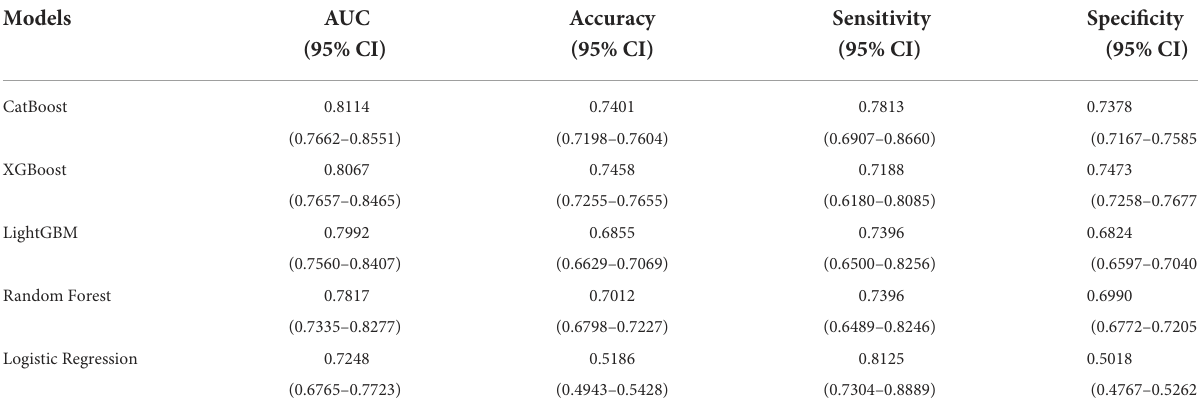
TABLE 3 Performance evaluation of the 5 prediction models.